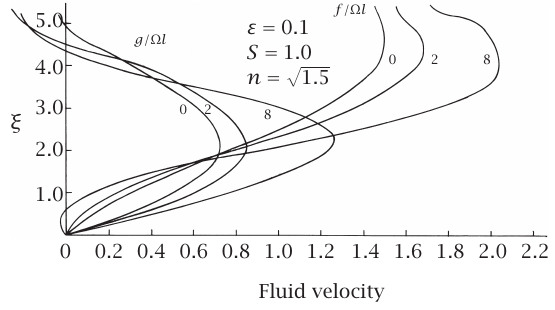
Figure 3.11 . Variations of f/ Ω l and g/ Ω l for different values of A , the mag- nitude of fluctuations in blowing velocity.